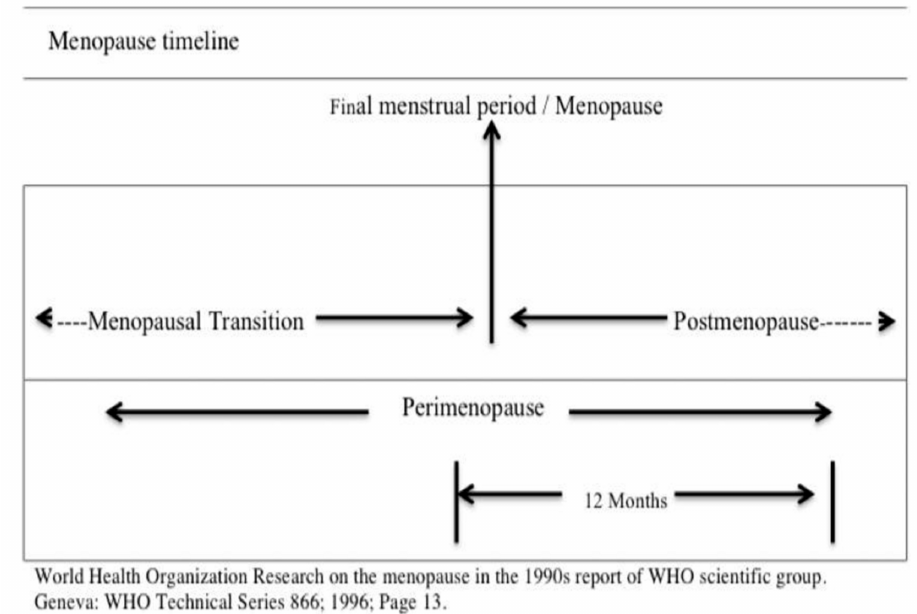
Figure 1. Menopause, perimenopause, and